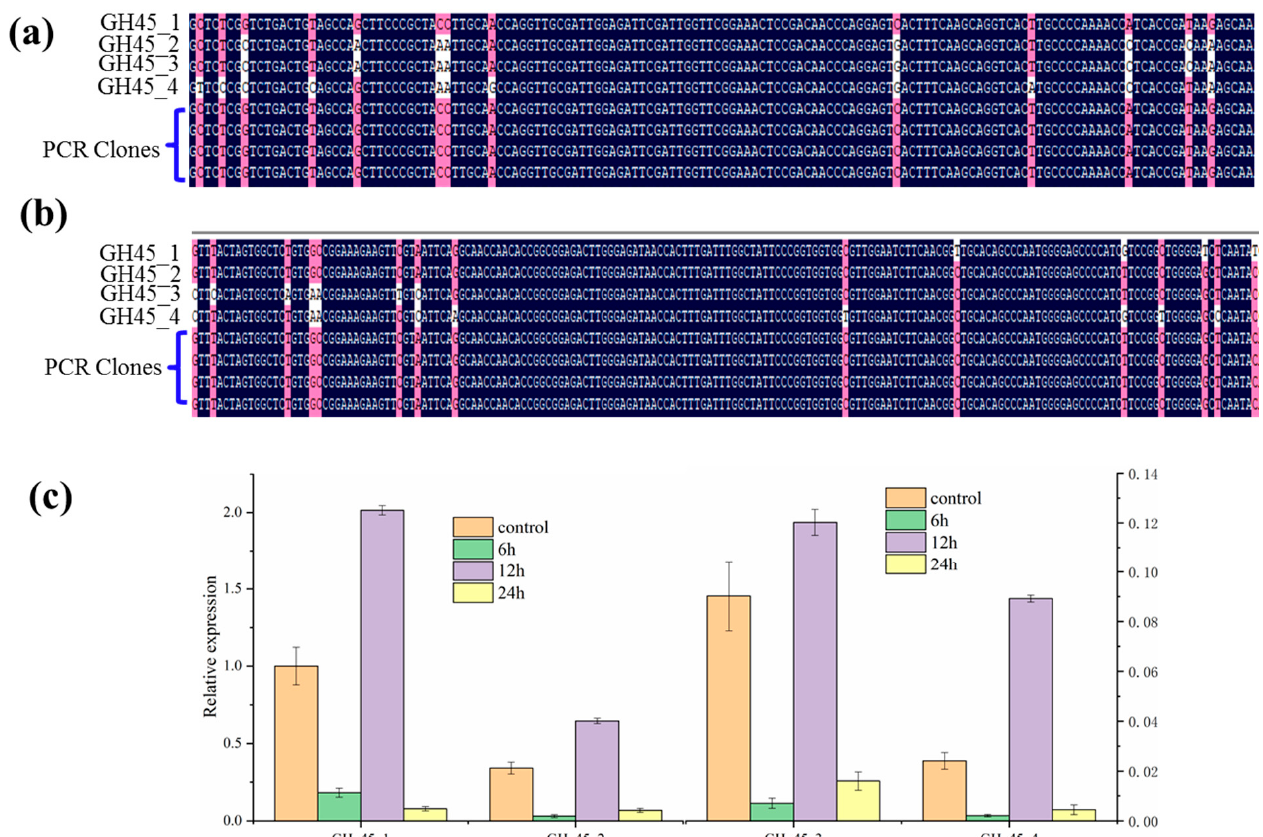
Figure 4. Expression profiling of four GH45 copies with the qPCR method. ( a ) Validation of GH45_1 qPCR primers by clone sequencing, ( b ) Validation of GH45_2 qPCR primers by clone sequencing and ( c ) Relative expressions of 4 GH45 genes.